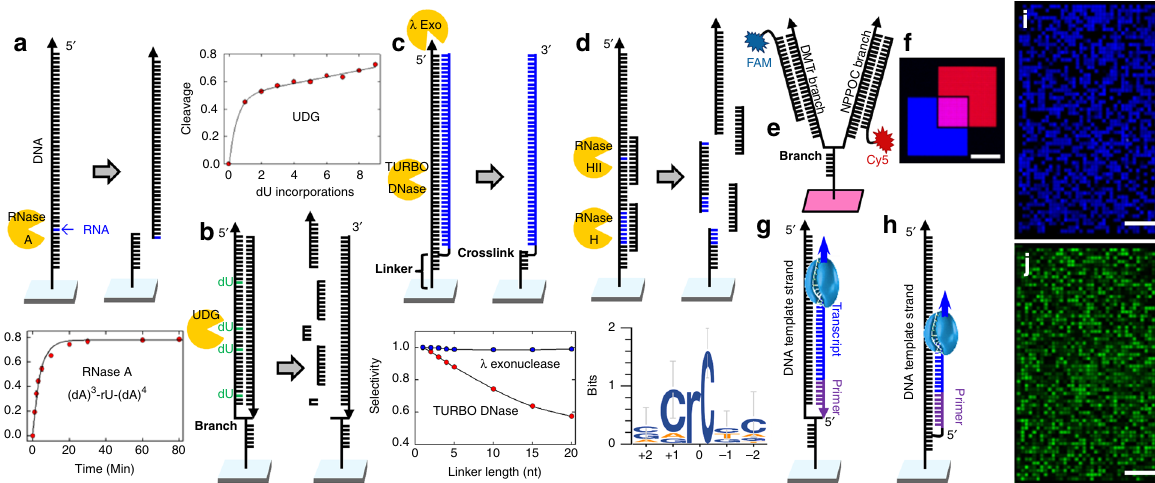
Fig. 4 Post-synthetic enzymatic processing (Level-Three patterning). Nucleic acid sequences can be selectively or programmably cleaved, digested, or transcribed enzymatically on the biochip. a RNase A is a fast and ef fi cient cleavage agent and requires only a single RNA nucleotide incorporation, optimally a pyrimidine surrounded by purines. b Similarly, uracil-DNA glycosylase (UDG) cleaves at pre-de fi ned dU positions, but is signi fi cantly less ef fi cient than RNase A cleavage. c Unmodi fi ed DNA can be digested by DNase I or lambda exonuclease. In the case of branched or crosslinked nucleic acid structures, lambda exonuclease digests only from a 5 ′ terminus and does not pass the junction, leaving the 3 ′ terminal DNA branch intact. DNase can be used if the second branch is not DNA and will not signi fi cantly digest a DNA surface linker shorter than a few nucleotides. d Programmable logical control of cleavage can be achieved with RNase H or HII; cleavage only occurs in conjunction with DNA hybridization to the cleavage site. RNase HII requires only a single RNA nucleotide incorporation at the desired cleavage site but has a preferred sequence context for maximum ef fi ciency. e Branched structures synthesized either with asymmetric branching phosphoramidites or through crosslinking, can be effectively combined with enzymatic processing. f Fluorescence scans showing branched structure labeled by hybridization to either or both branches (200 µ m scale bar). g Transcription of a DNA template using a branched structure. The primer is synthesized on the second branch using reverse phosphoramidites, or h attached by crosslinking. In either case the primer can be elongated as DNA or RNA using appropriate polymerases. i Fluorescence scan of branched structured synthesized via templated